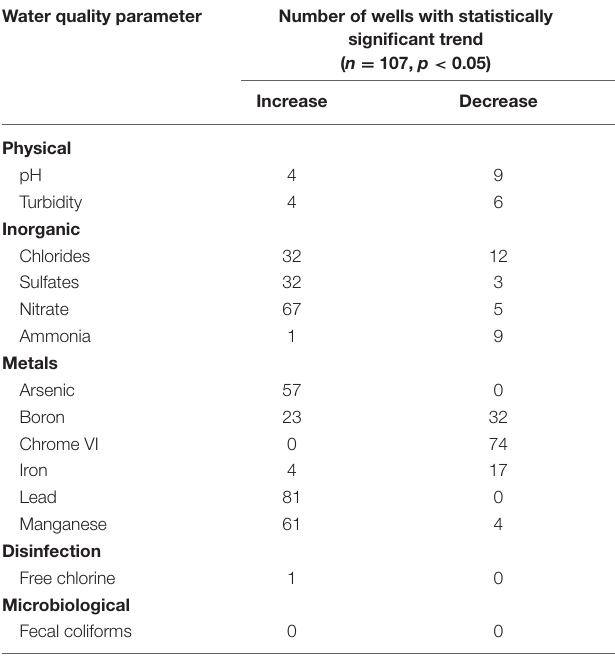
TABLE 3 | Groundwater quality trend during the period 2002–2017 in Mexico City. Water quality